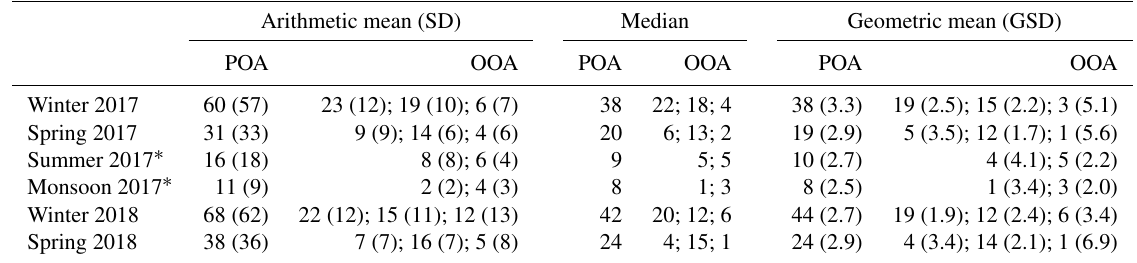
Table 4. Organic component of the organic–inorganic combined PMF factor concentrations (µgm − 3 ) split into POA and OOA. We were able to separate OOA into AN-OOA, AS-OOA, and AC-OOA.